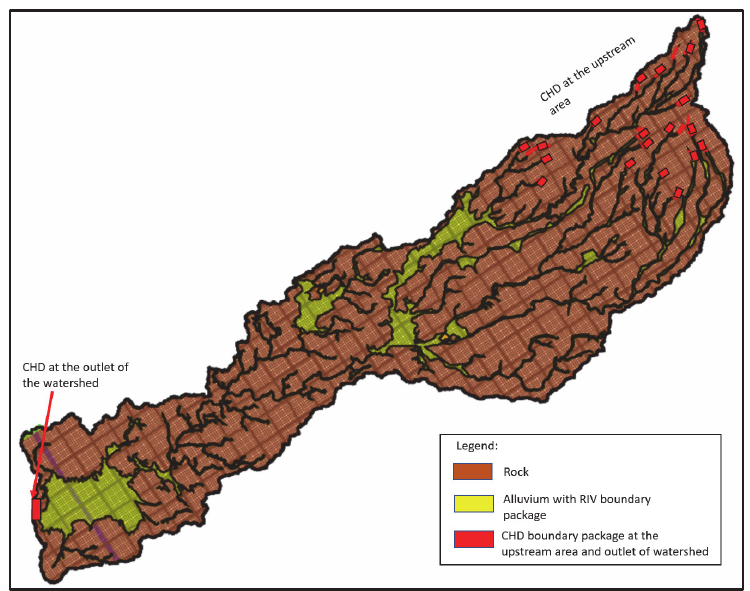
Figure 27. Transient groundwater modeling appearances on MODFLOW 6 in Scenario 2, involve several boundary conditions packages (i.e., CHD, EVT, RCH, and RIV). The EVT and RCH are applied to the whole watershed.